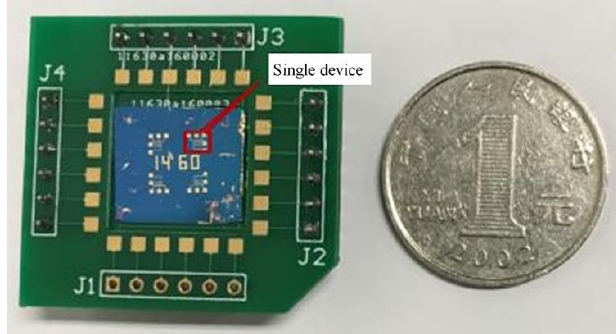
Figure 12. Physical drawings of devices on PCB.